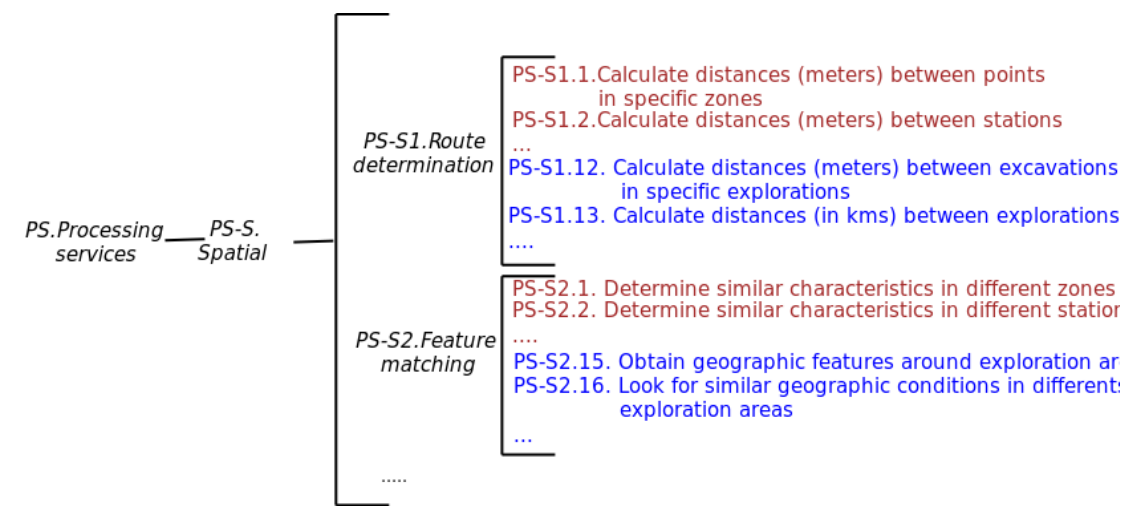
Figure 12. Relocated services in the User Processing